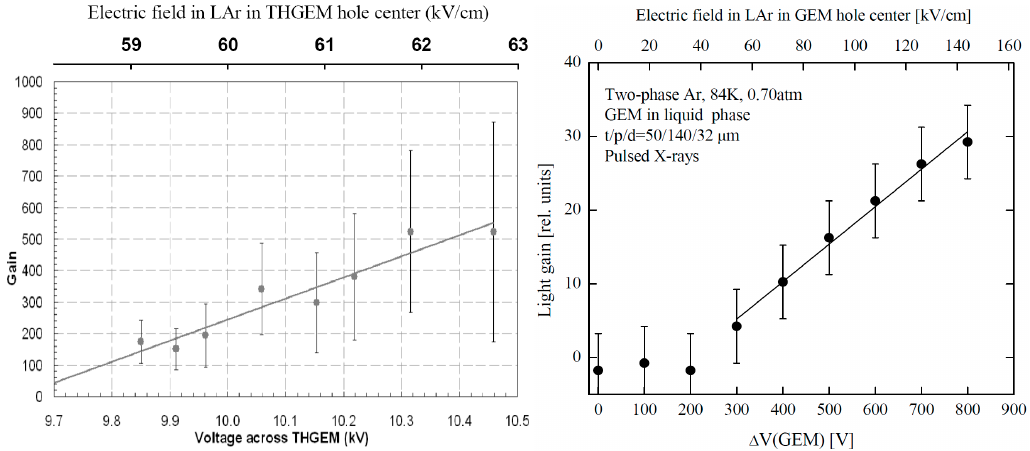
Figure 28. Relative amplitude of the proportional EL signal generated in THGEM (left) [4,49] and GEM (right) [4] plate immersed in liquid Ar as a function of the voltage across the plate. The appropriate electric fields in the THGEM and GEM hole centers are shown on the top axes.